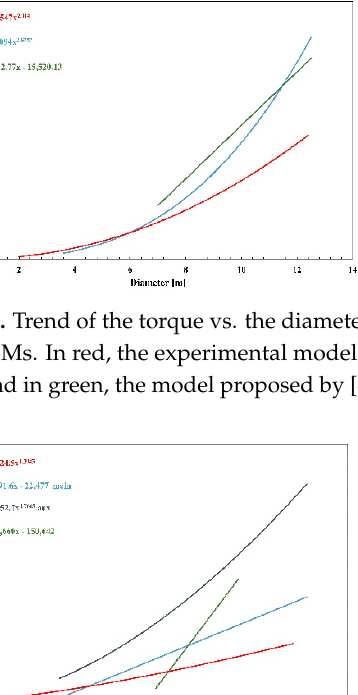
Figure 26. Trend of the torque vs. the diameter based on data collected from the analysis of double shield TBMs. In red, the experimental model proposed in this study; in blue, the model proposed by [42] and in green, the model proposed by [43].